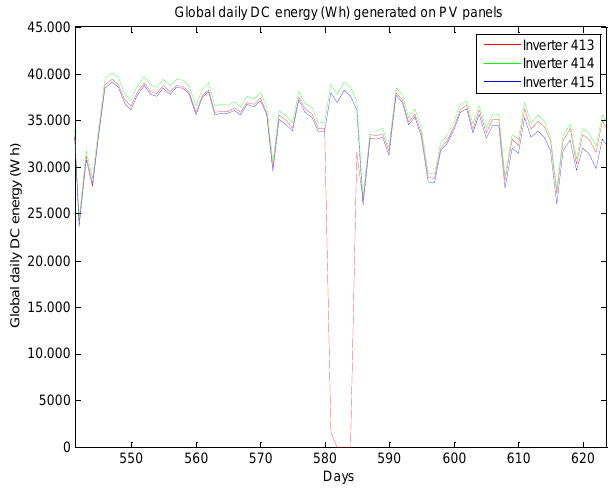
Figure 6. Total daily DC energy generated in the PV arrays connected to inverters, from 23 June 2012 to 15 September 2012.